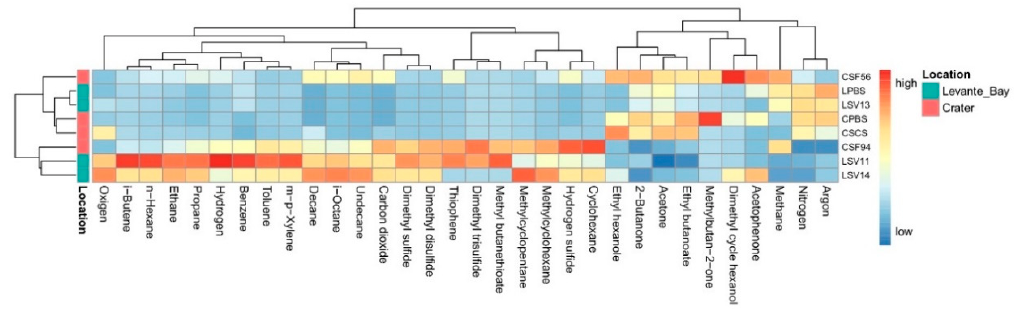
Figure 1. Heatmap showing the scaled measures of detected interstitial soil gases.